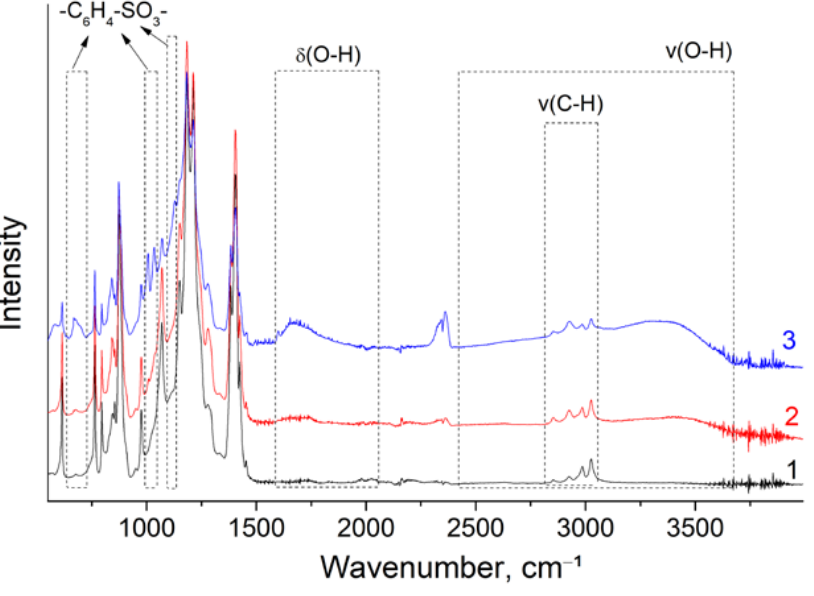
Figure 8. FTIR spectra of the initial PVDF film (1), and MCG-0 (2) and MCG-3 (3) membranes after the accelerated stress tests.